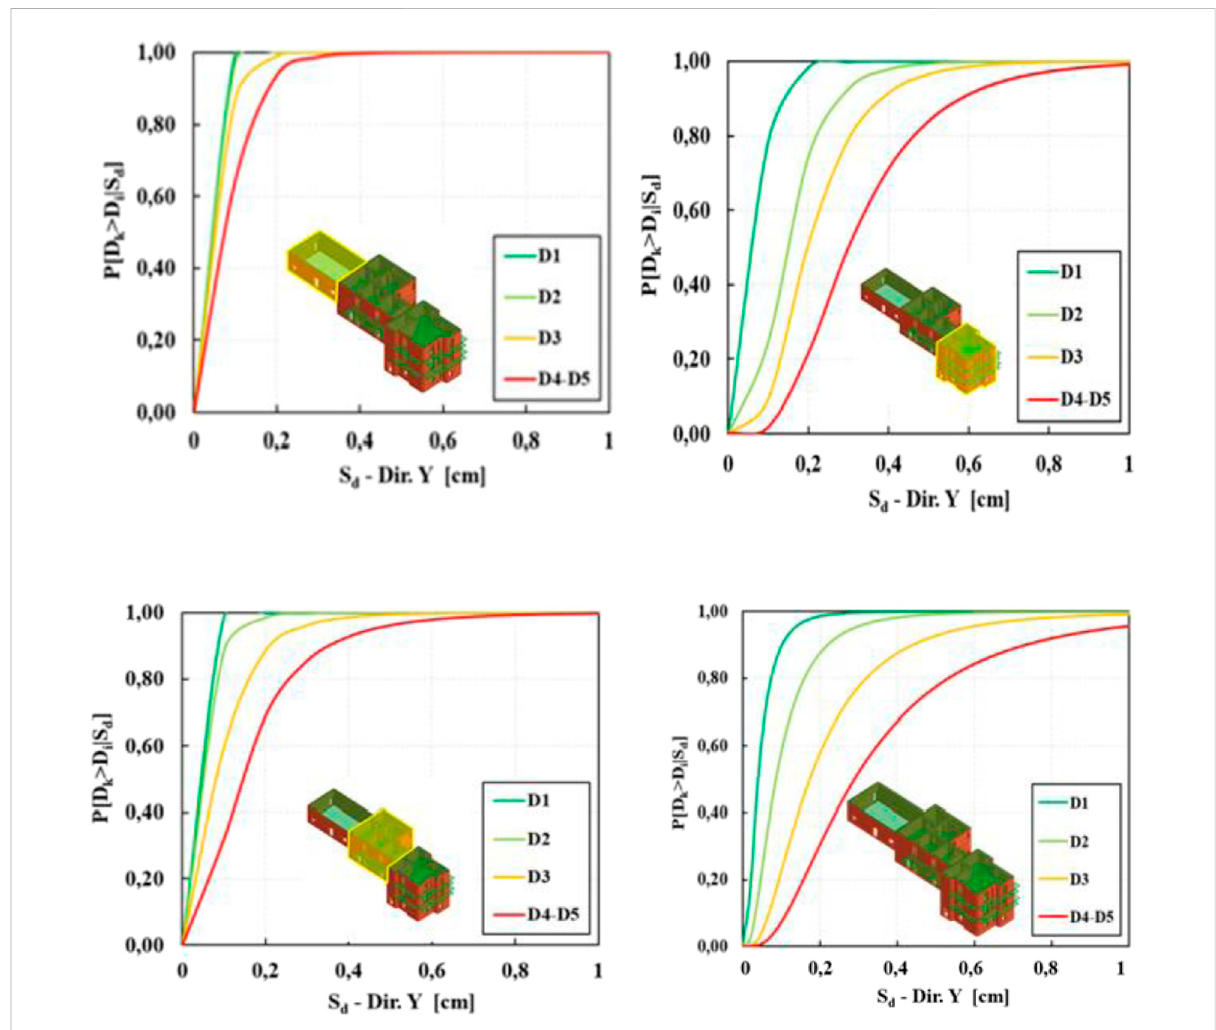
FIGURE 7 Fragility curves of SU and building aggregate in direction